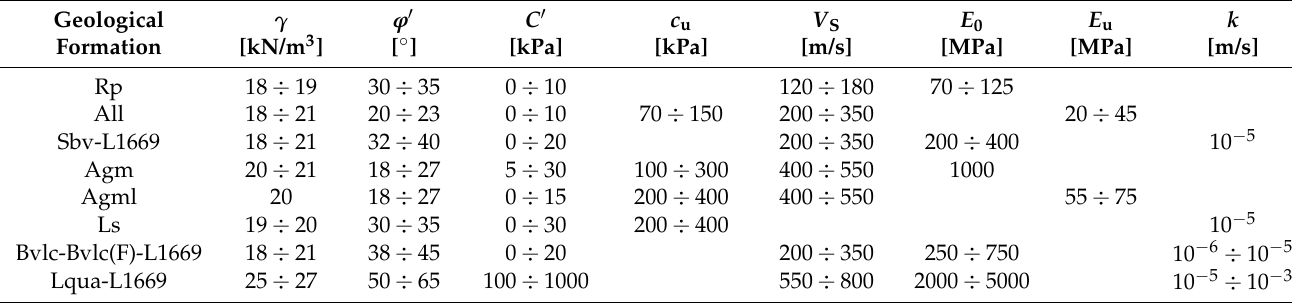
Table 1. Geotechnical parameter for each geological